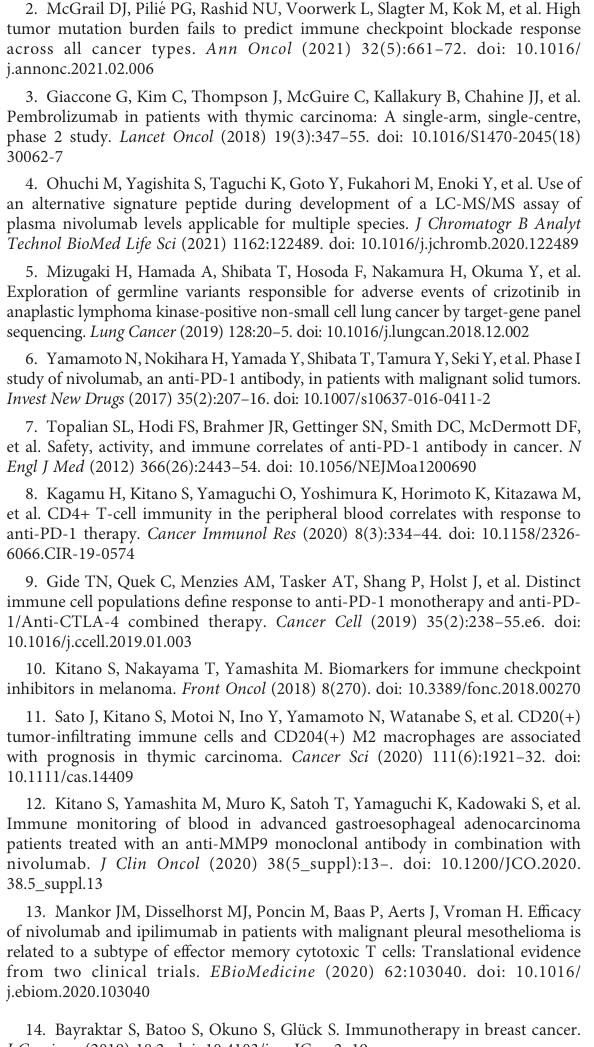
SUPPLEMENTARY TABLE 3 List for NCC immuno pharmacogenomic (PGx) analysis